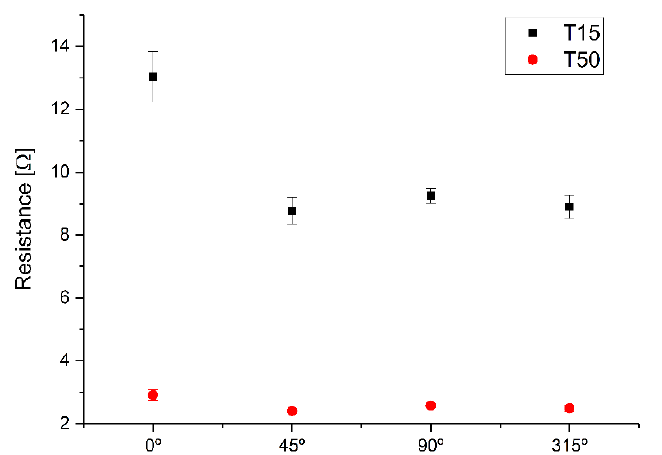
Figure 7. Average of the resistance of the set of tracks of 15 and 50 mils (0.381 and 1.27 mm) printed with M5 ink as a function of the printing orientation.